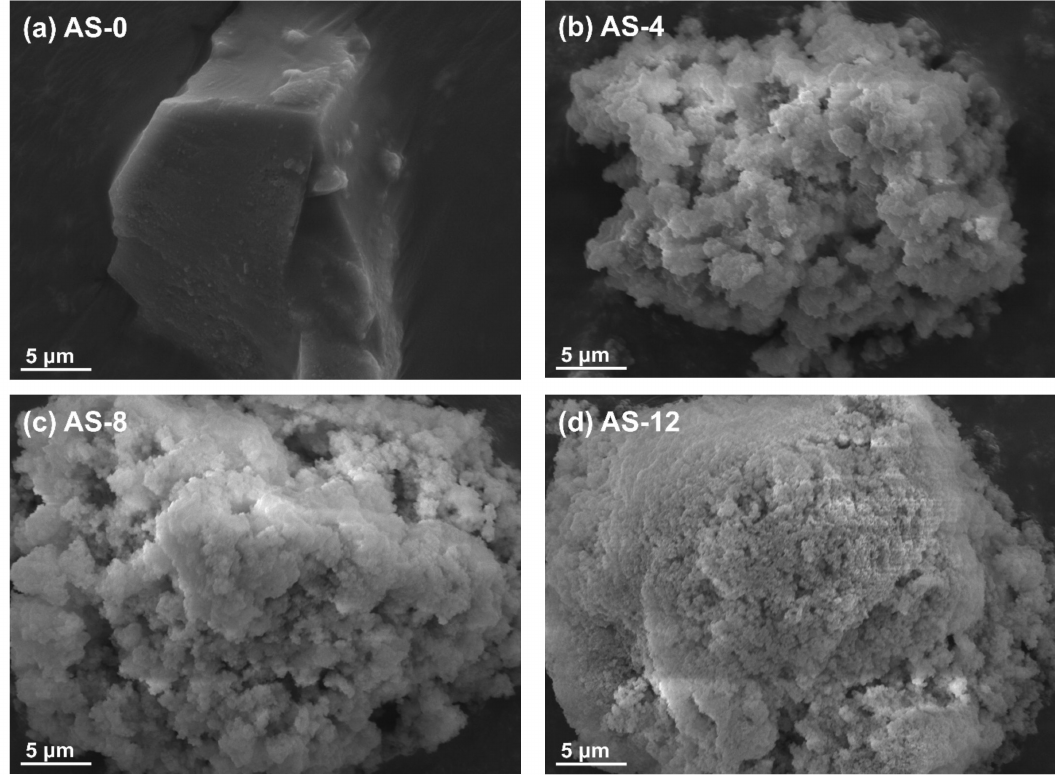
Figure 4. SEM images of the synthesized aluminum silicate powder according to different